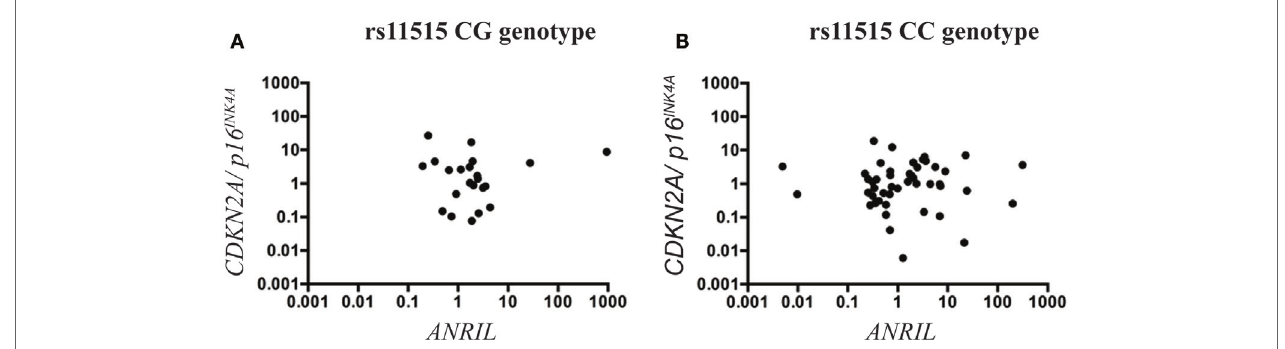
FigUre 3 | scatterplots illustrating the interaction between rs11515 genotypes and ANRIL on CDKN2A/p16 INK4a gene expression in heart tissue. The CG genotype (a) and the CC (B) genotype in heart tissue showed was no correlation between ANRIL and CDKN2A/p16 INK4a expression